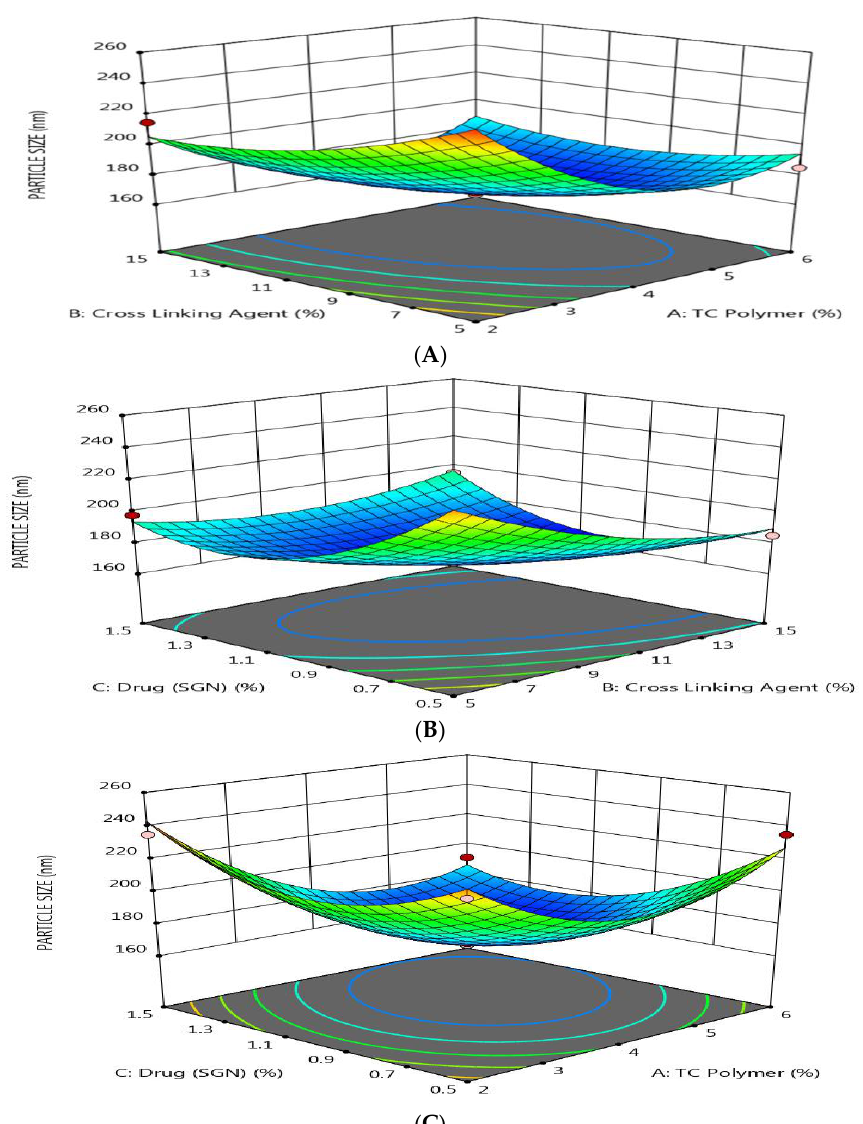
Figure 1. Response surface methodology for the effect of the formulation factors (X 1 , X 2 , and X 3 ) on the particles size of SGN–TC nanoparticles. ( A ) Effect of polymer and crosslinking agent concentration on particle size, ( B ) Effect of crosslinking agent and drug concentration on particle size, ( C ) Effect of polymer and drug concentration on particle size.